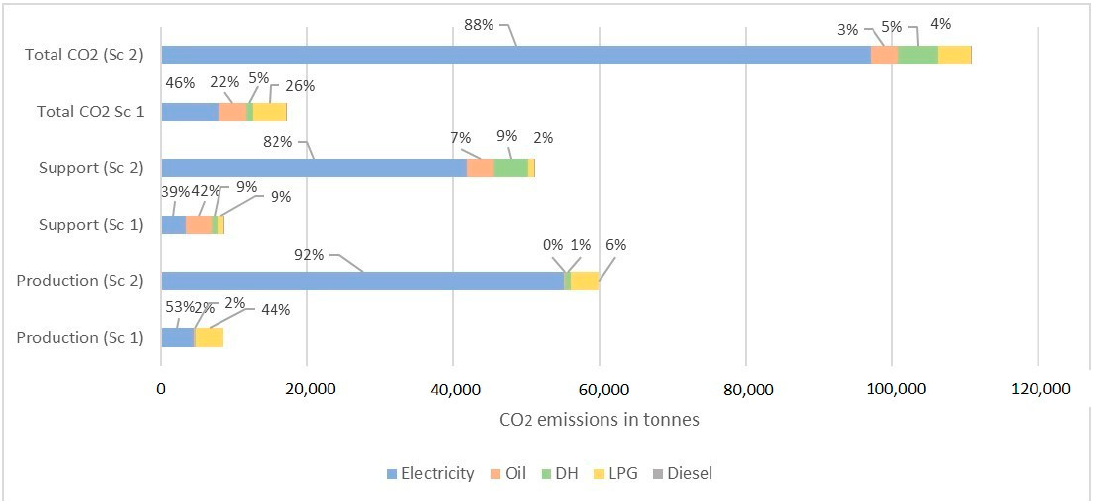
Figure 13. Share of CO 2 emissions from different energy carriers for the production and support processes of the Swedish engineering industry. Sc1—Scenario 1, Sc2—Scenario 2. Percentage in order of electricity, oil, district heating (DH), LPG.